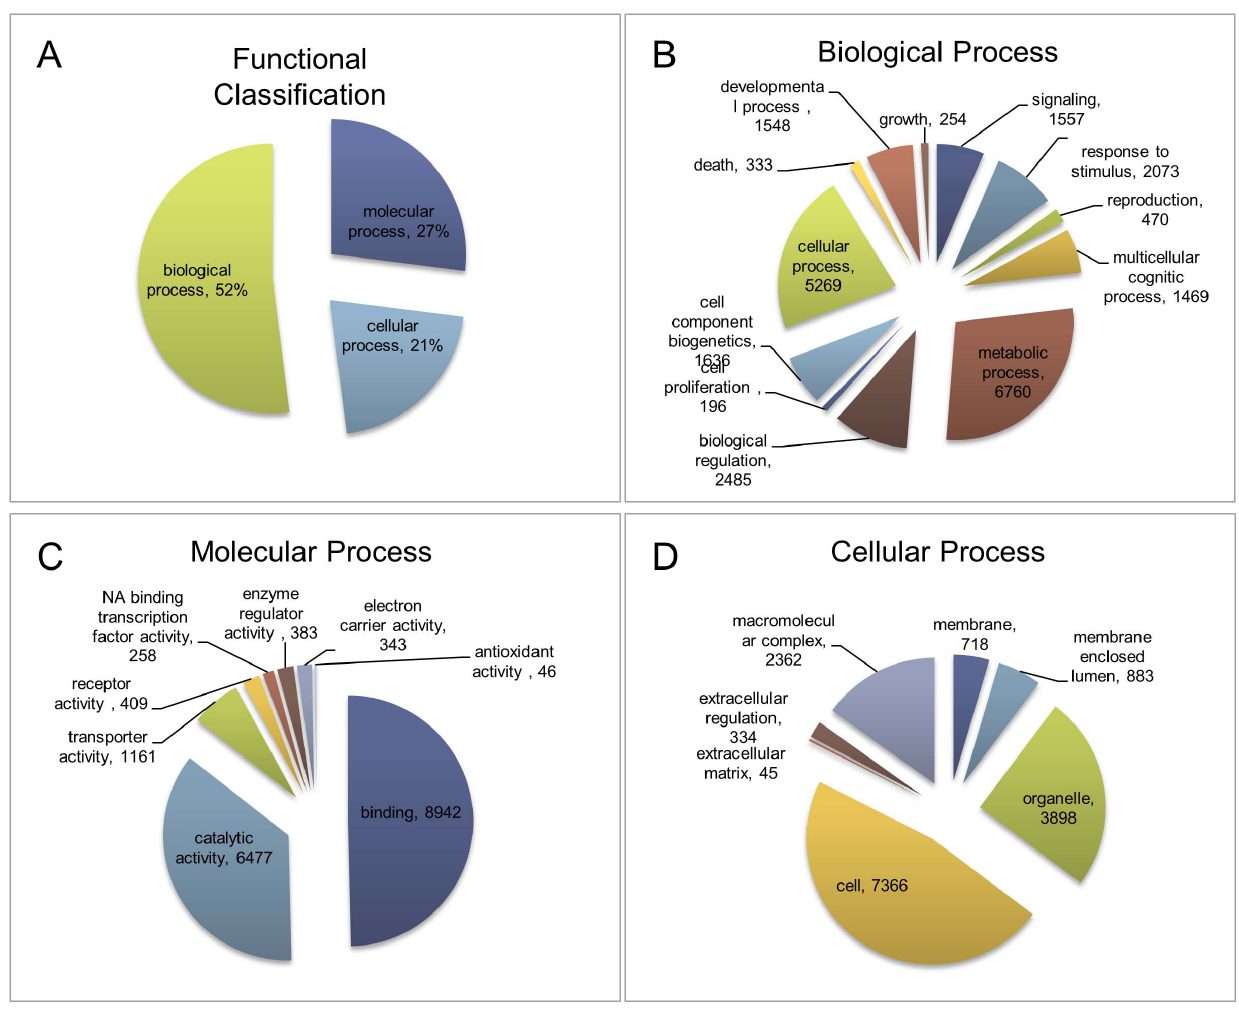
Figure 3. Functional distribution of deduced proteins of the H.vitripennis transcriptome. Pie diagrams showing A ) Functional distribution of deduced proteins B ) Biological classification of deduced proteins C ) Molecular distribution of deduced proteins and D ) Cellular distribution of deduced H. vitripennis proteins.